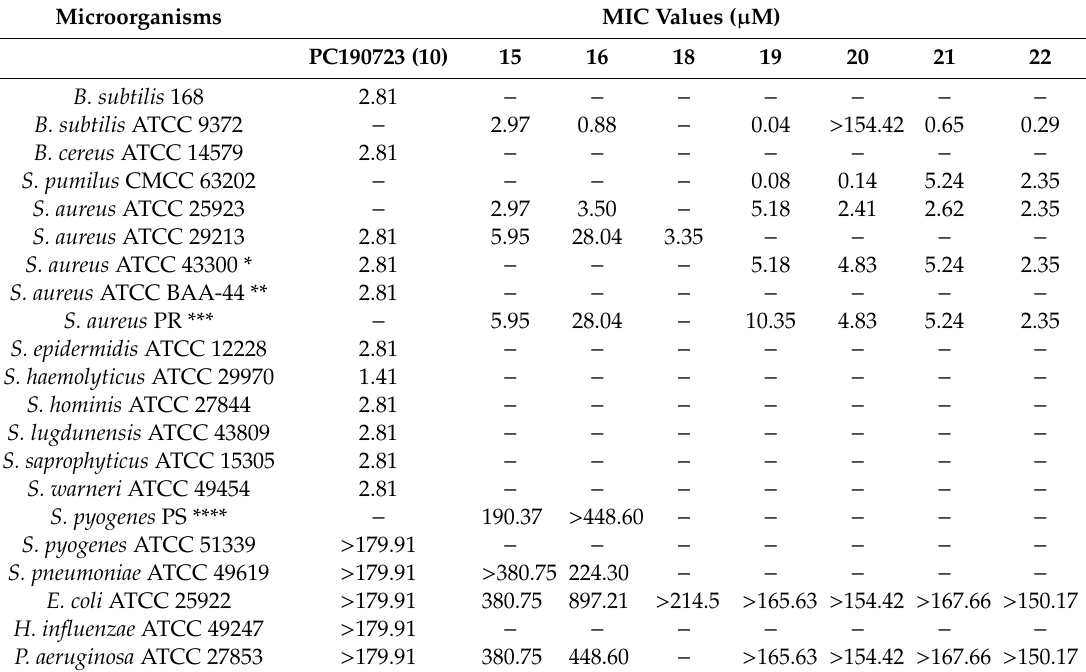
Table 1. Minimum inhibitory concentrations of the benzamide